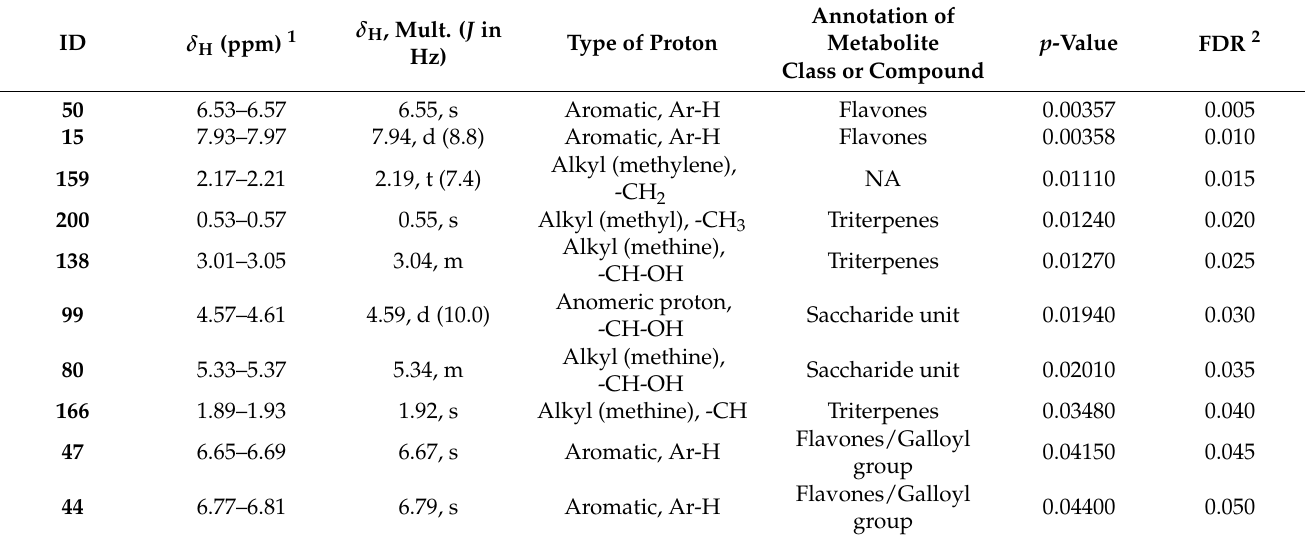
Table 1. Discriminant features for the MS-NMR fused data that contribute to the differentiation of the seasonal harvests of T. catappa samples.